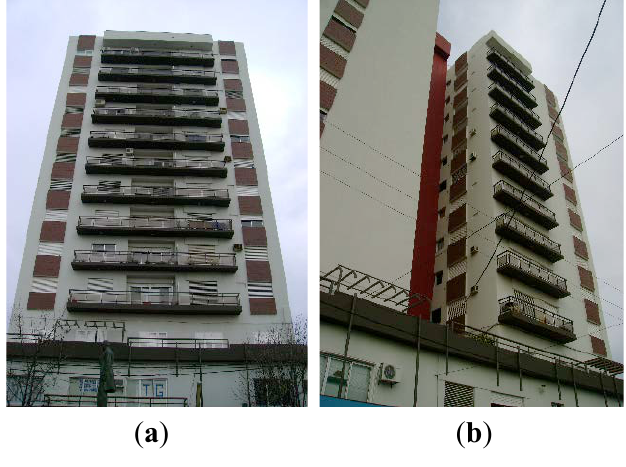
Figure 4. Building’s Views. ( a ) North façade; and ( b ) Northwestern